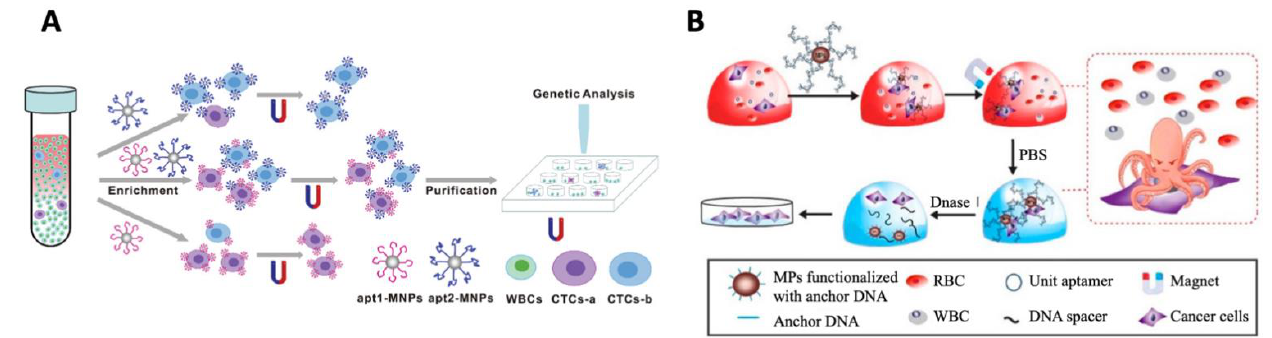
Figure 5. Aptamer-based cell isolation. ( A ) Aptamer-MNPs cocktail for CTC enrichment prior to genetic analysis. Adapted with permission from [111]. Copyright 2018 WILEY-VCH Verlag GmbH & Co. KGaA, Weinheim. ( B ) Aptamer-functionalized MNP, mimicking the tentacles of an octopus for efficient CTC capture. Adapted with permission from [57]. Copyright 2019, American Chemical Society.